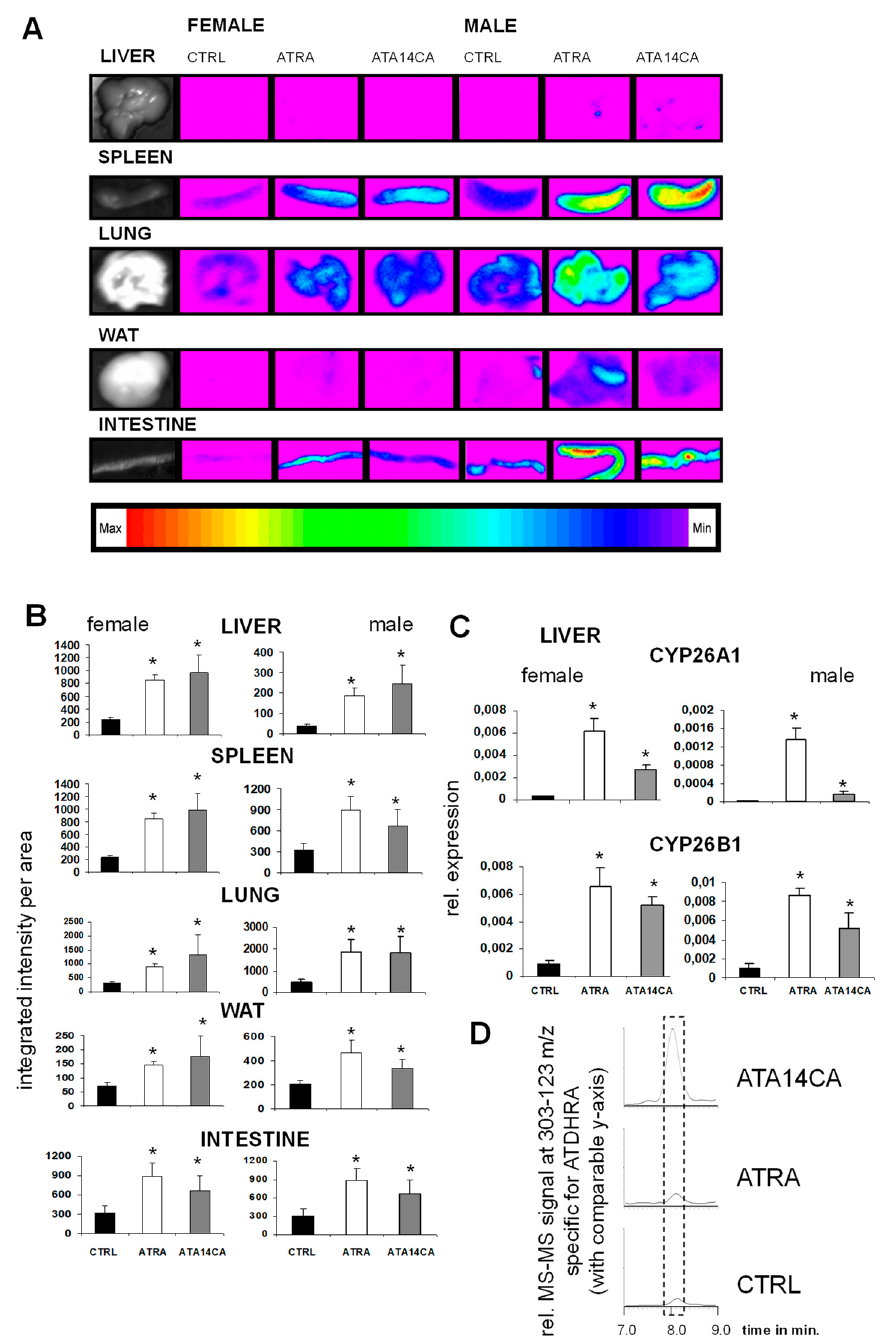
Figure 2. All- trans -apo-14´-carotenoic acid (ATA14CA) induces retinoic acid response element (RARE)-mediated signalling and RAR-target gene expression in RARE/DR5-luciferase reporter animals. ( A ) RARE/DR5-luc bioimaging of liver, spleen, lung, white adipose tissue (WAT), and intestine from male and female mice. These animals were treated with CTRL (vehicle treatment), all- trans retinoic acid (ATRA) (50 mg/kg bw), or ATA14CA (equimolar to ATRA-treatment with 54.3 mg/kg bw). ( B ) Quantification of the RARE/DR5-luc bioimaging data. ( C ) Quantitative real time-polymerase chain reaction (QRT-PCR) based analysis of the retinoid target genes CYP26A1 and CYP26B1 in liver of male and female mice. Significant values were marked with a *, when p ≤ 0.05 vs. CTRL. ( D ) Representative chromatograms showing increased concentrations of ATDHRA (identified using MS-MS of 303–123 m/z and marked by a dashed lined box) in mouse serum after CTRL, ATRA, and ATA14CA treatments.